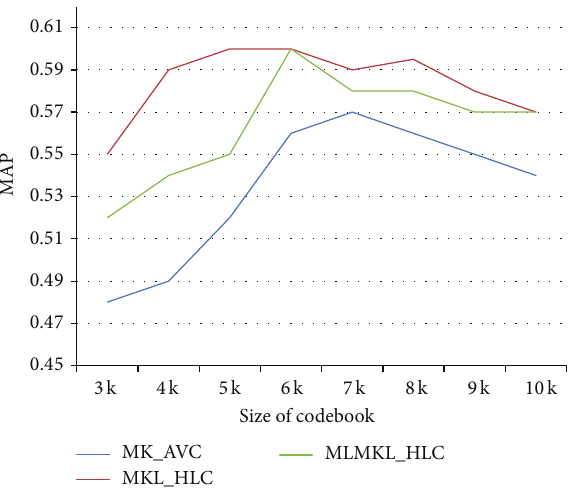
Figure 5: Performance of different codebook size for CCV